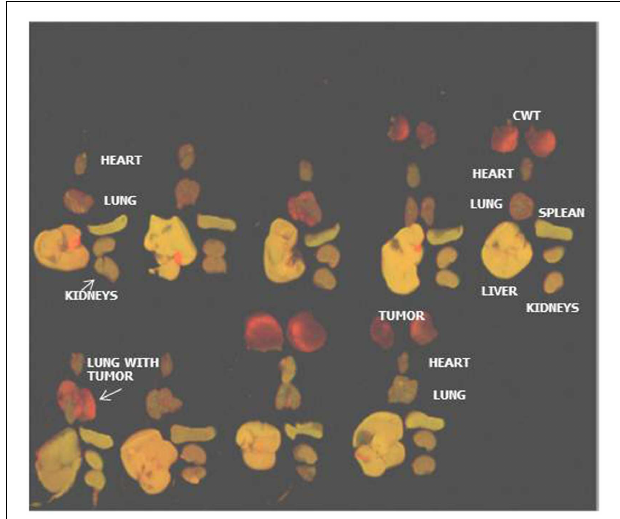
FIGURE 3 | MSCs home preferentially to the lung. Tracking of the injected MSCs was completed by labeling the cells with quantum dots followed fluorescent imaging 6h after injection. MSC injection was done after established chest wall tumors were 1cm in size.The majority of MSCs remain within the lung parenchyma with very few found within the primary chest wall tumors. It is important to note that the MSCs remain within the lung in groups with or without pulmonary metastasis.This tracking experiment was repeated with lung epithelial cells (CRL2300) with similar results (cells remained sequestered in lung parenchyma with few found in primary chest wall tumors) (CWT, chest wall tumor; LM, lung metastasis).